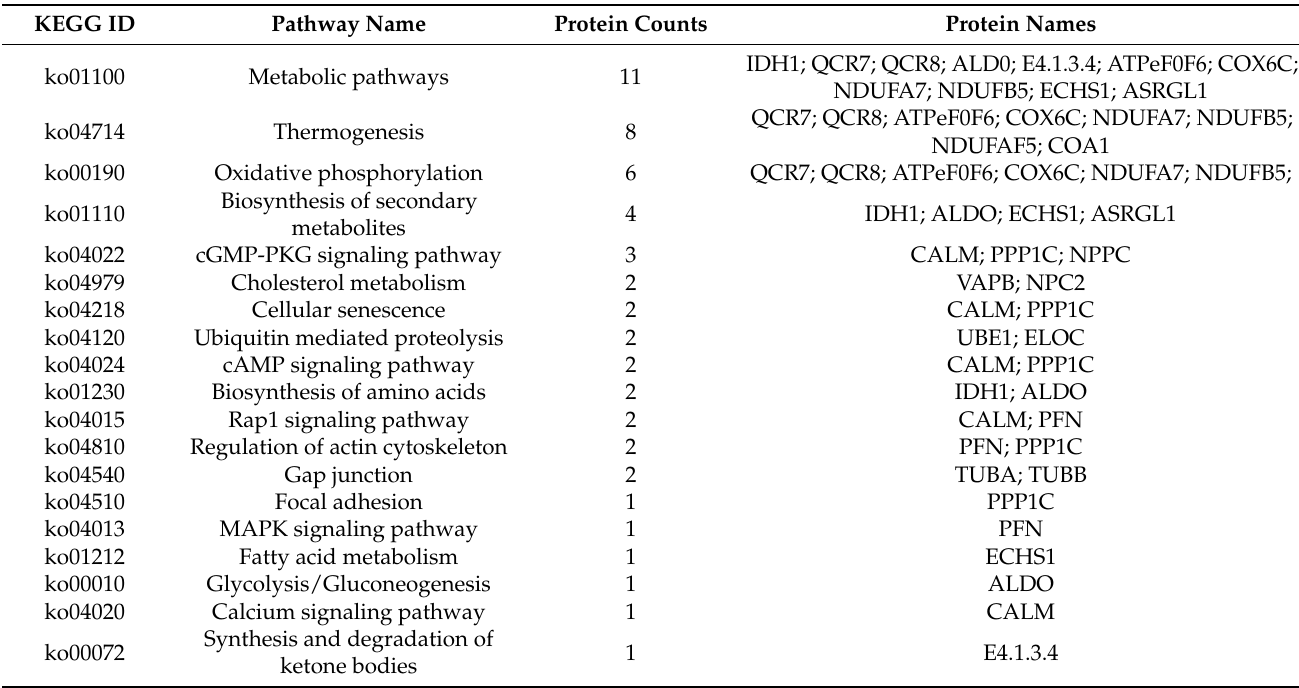
Table 1. KEGG pathway analysis of